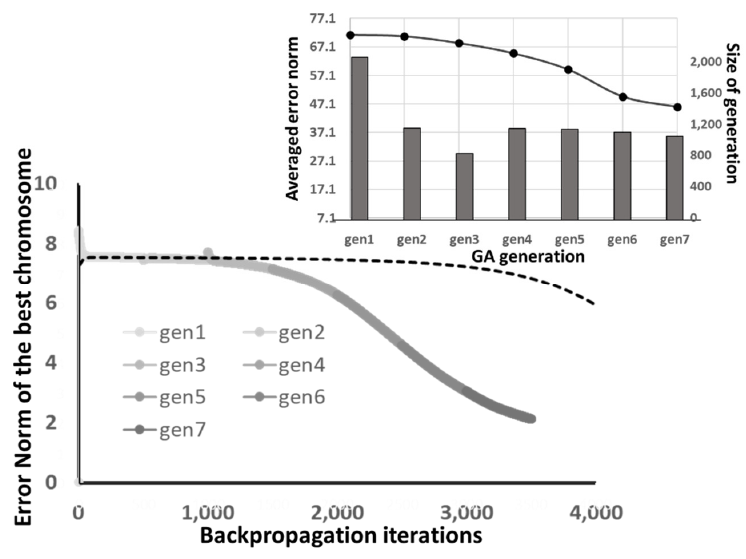
Figure 17. The performance of the GA generations under the “progressing” optimizer. Table 6. The ANN training result under GA “progressing” optimizer.